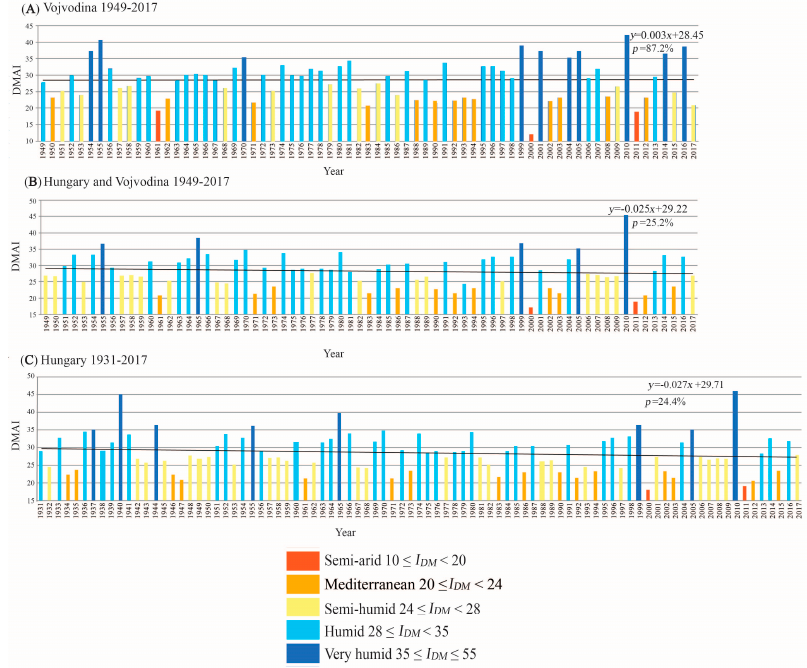
Figure 9. The distribution of the mean annual De Martonne Aridity Index and its trend for: ( A ) Vojvodina during the period 1949 – 2017, ( B ) Hungary and Vojvodina presented jointly during the period 1949 – 2017, and ( C ) Hungary during the period 1931 – 2017. The aridity trend is presented with a solid, black line and trend equation, and p is the